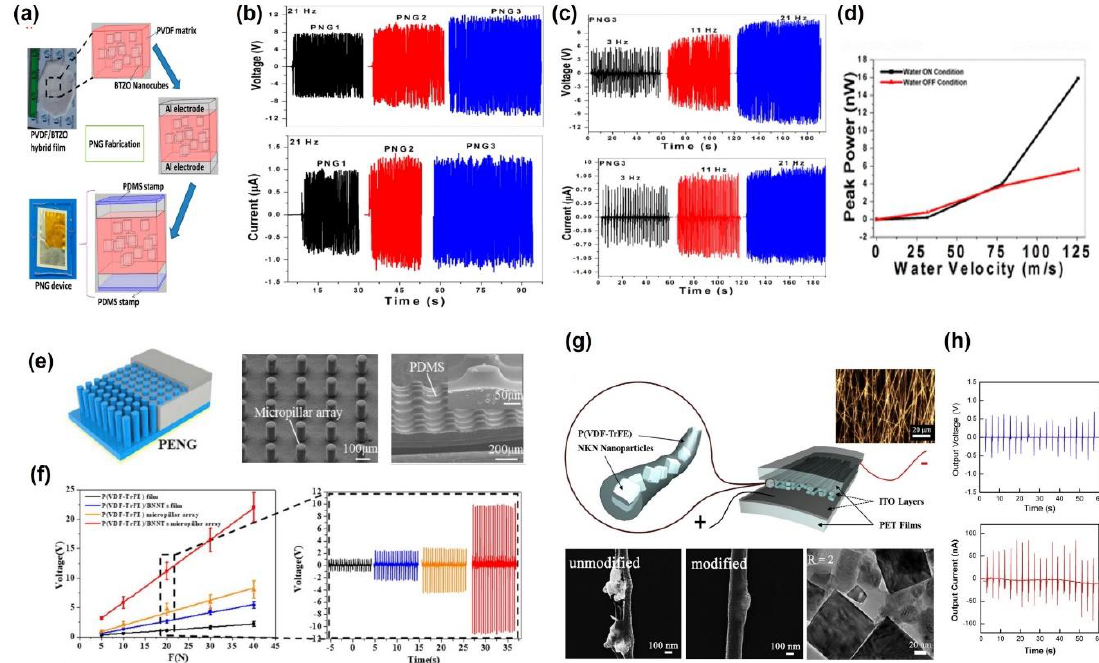
Figure 5. ( a ) Schematic diagram of the key steps of the BZTO/PVDF PENG manufacturing. ( b ) Comparison of the electrical output voltage and the current of the BTO/PVDF, BT (1-x) Z (x) O(x =